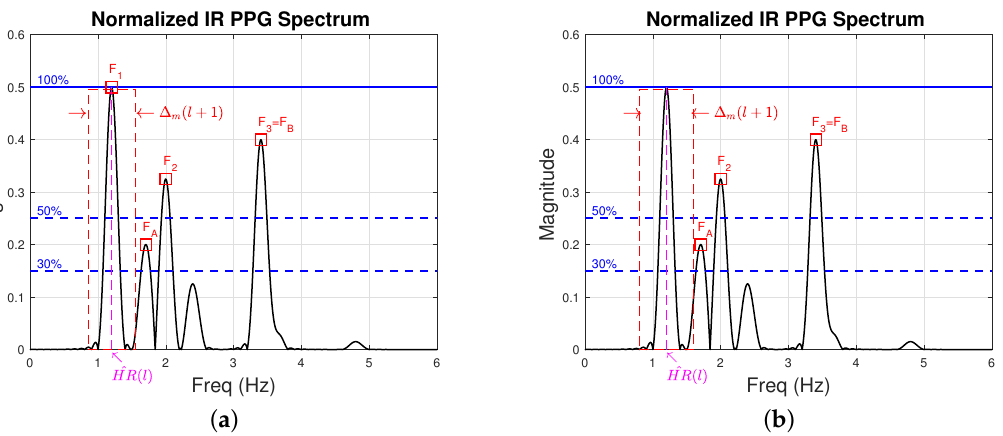
Figure 7. Frequency spectrum of a typical IR PPG signal. ˆ HR ( l ) is the heart-rate estimate at time step l . ∆ m ( l + 1 ) is the “medium search range” represented by a red dashed rectangle. The frequency components we obtained from step 1 and 2, namely, F 1 , F A , F 2 , and F 3 = F B , are represented by red squares. In ( a ) frequency F 1 falls within ∆ m ( l + 1 ) . In ( b ) we discard the frequency F 1 since it falls within ∆ m ( l + 1 ) and leave the rest in N noise ( F A , F 2 , and F 3 = F B